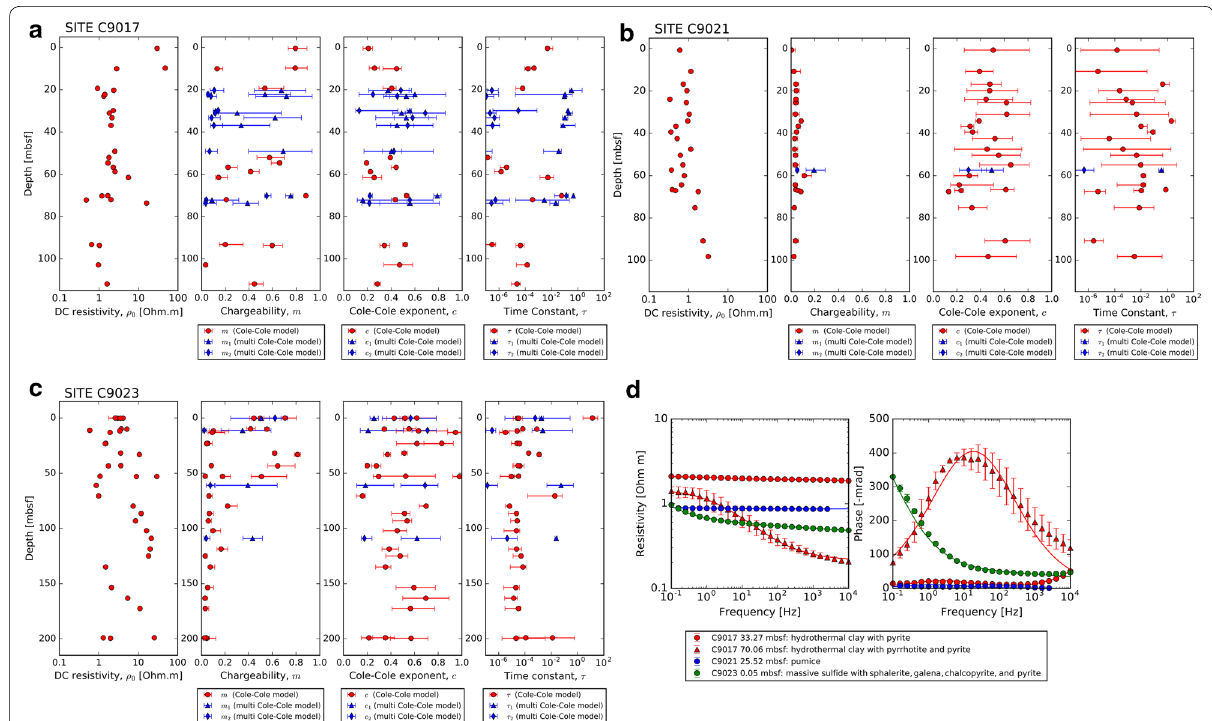
Fig. 4 Results of IP parameter estimation for a site C9017, b site C9021, and c site C9023. d Some fits of the spectra by the Cole–Cole